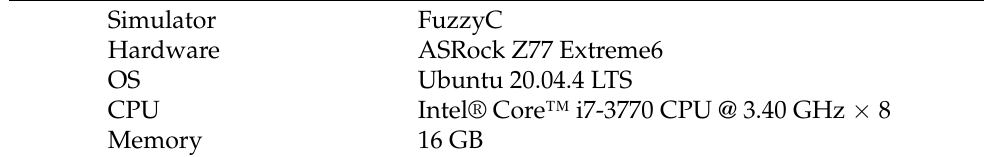
Table 3. Testing environment.